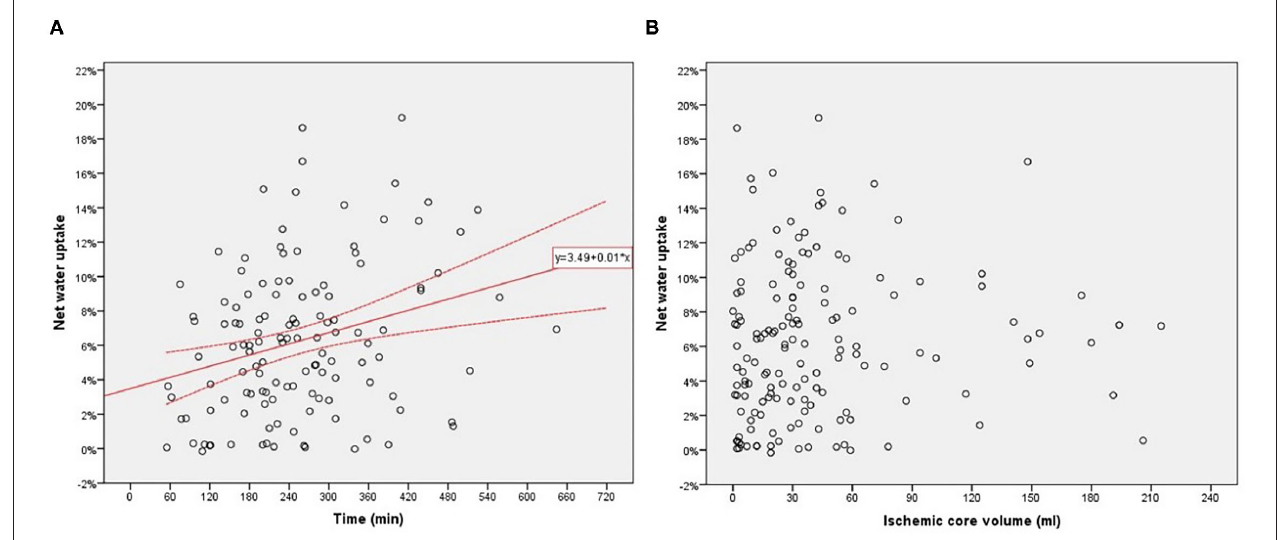
FIGURE 3 | (A) Relationship between net water uptake (NWU) within the ischemic core and infarct time from onset to imaging. (B) Relationship between NWU within ischemic core and core volume.